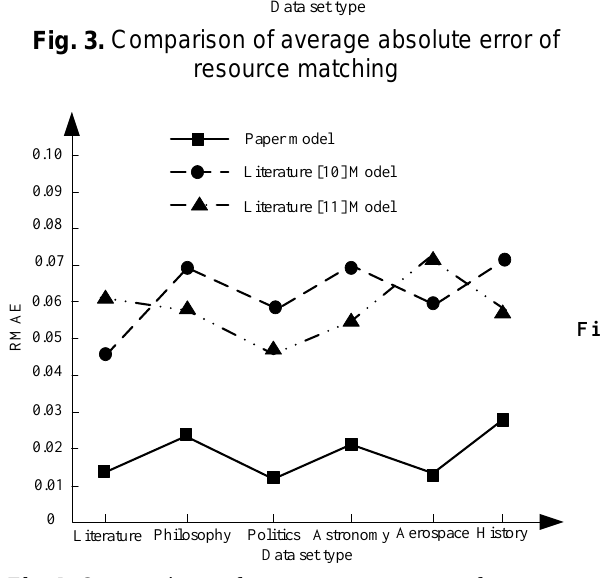
Fig.4. Comparison of mean square error of resource